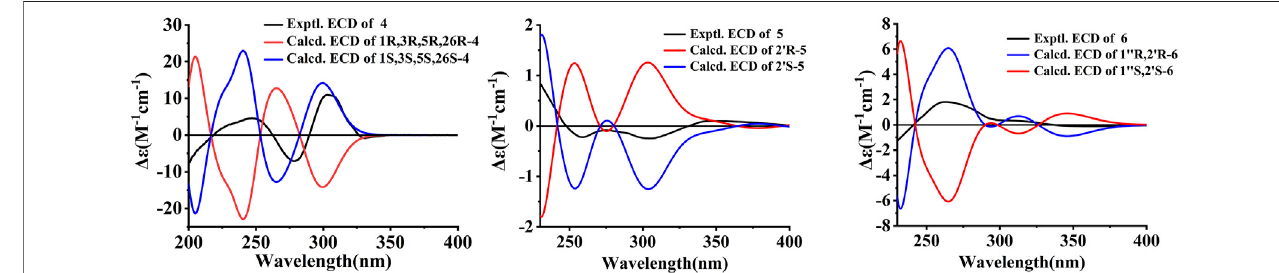
FIGURE 5 | Experimental and the calculated ECD spectra of compounds 4-6 .